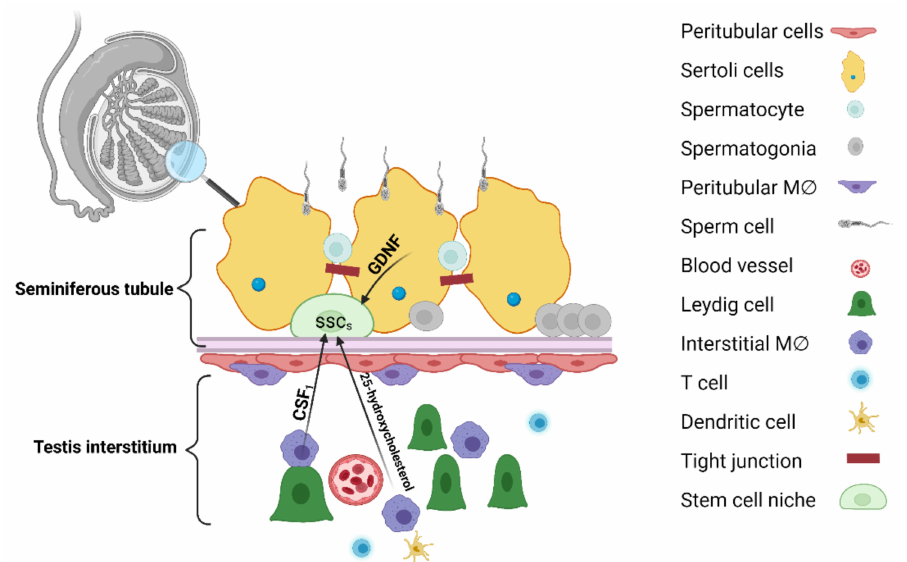
Figure 5. Overview of the testicular stem cell niche. The interstitial region is composed mainly of vascular structures, Leydig cells that produce testosterone, and macrophages. The spermatogonial stem cell (SSC) niche is located in the proximity of the basement membrane that separates the interstitium from the peritubular area. Adjacent Sertoli cells found in the seminiferous tubules form tight junctions that participate in the formation of the blood-testis barrier. In the testis, two populations of macrophages have been described: those that lie on the surface of the seminiferous tubules in the proximity of the peritubular myoid cells, comprising the peritubular population, and those located in the interstitium, intimately associated with Leydig cells. Colony stimulating factor 1 (CSF1), glial cell line-derived neurotrophic factor (GDNF), macrophage (M Φ ). Created with BioRender.com (accessed on: 7 March